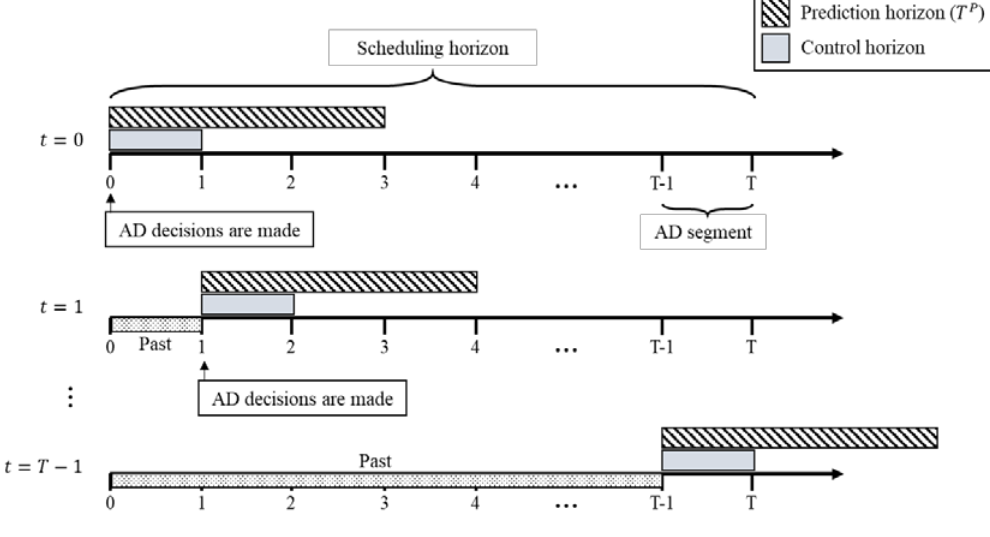
Figure 2. Rolling-horizon optimization framework.